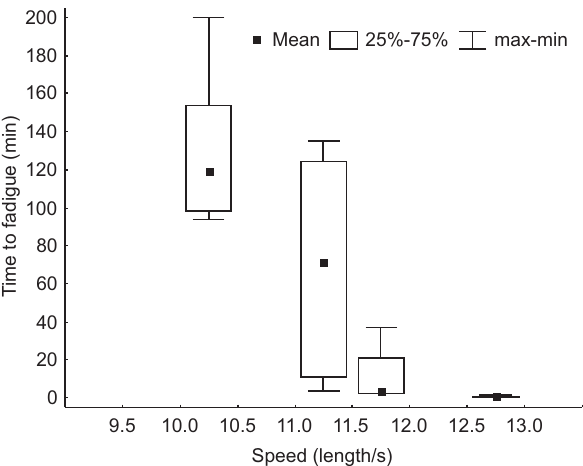
Figure 7. Time to fatigue per speed class (length/s) for B. stramineus